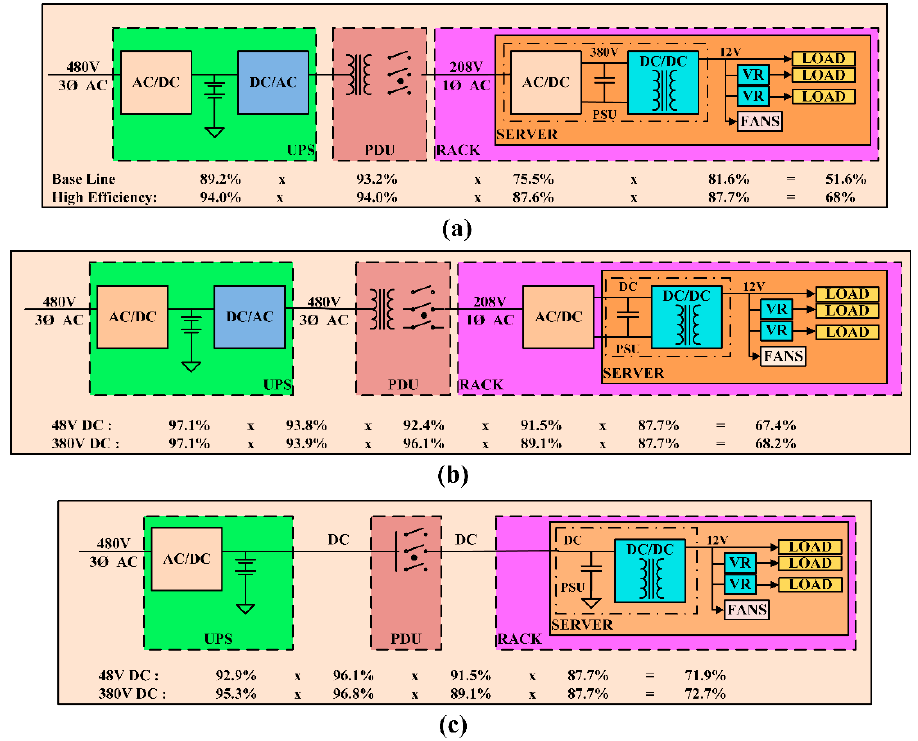
Figure 3. Power architectures in telecom and data centers: ( a ) conventional AC architecture; ( b ) rack-level DC architecture; ( c ) facility-level DC architecture [4].